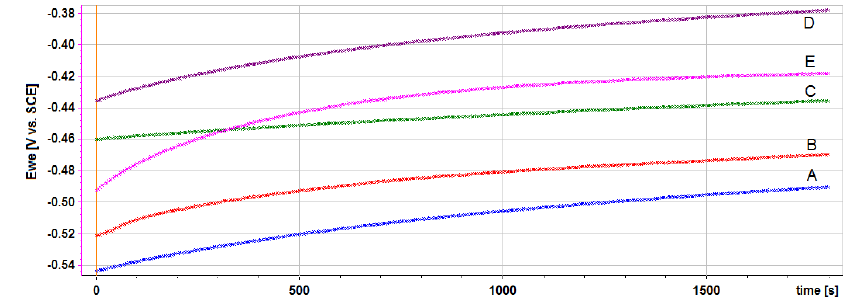
Figure 12. Course of the open circuit potential (OCP) during stabilization.